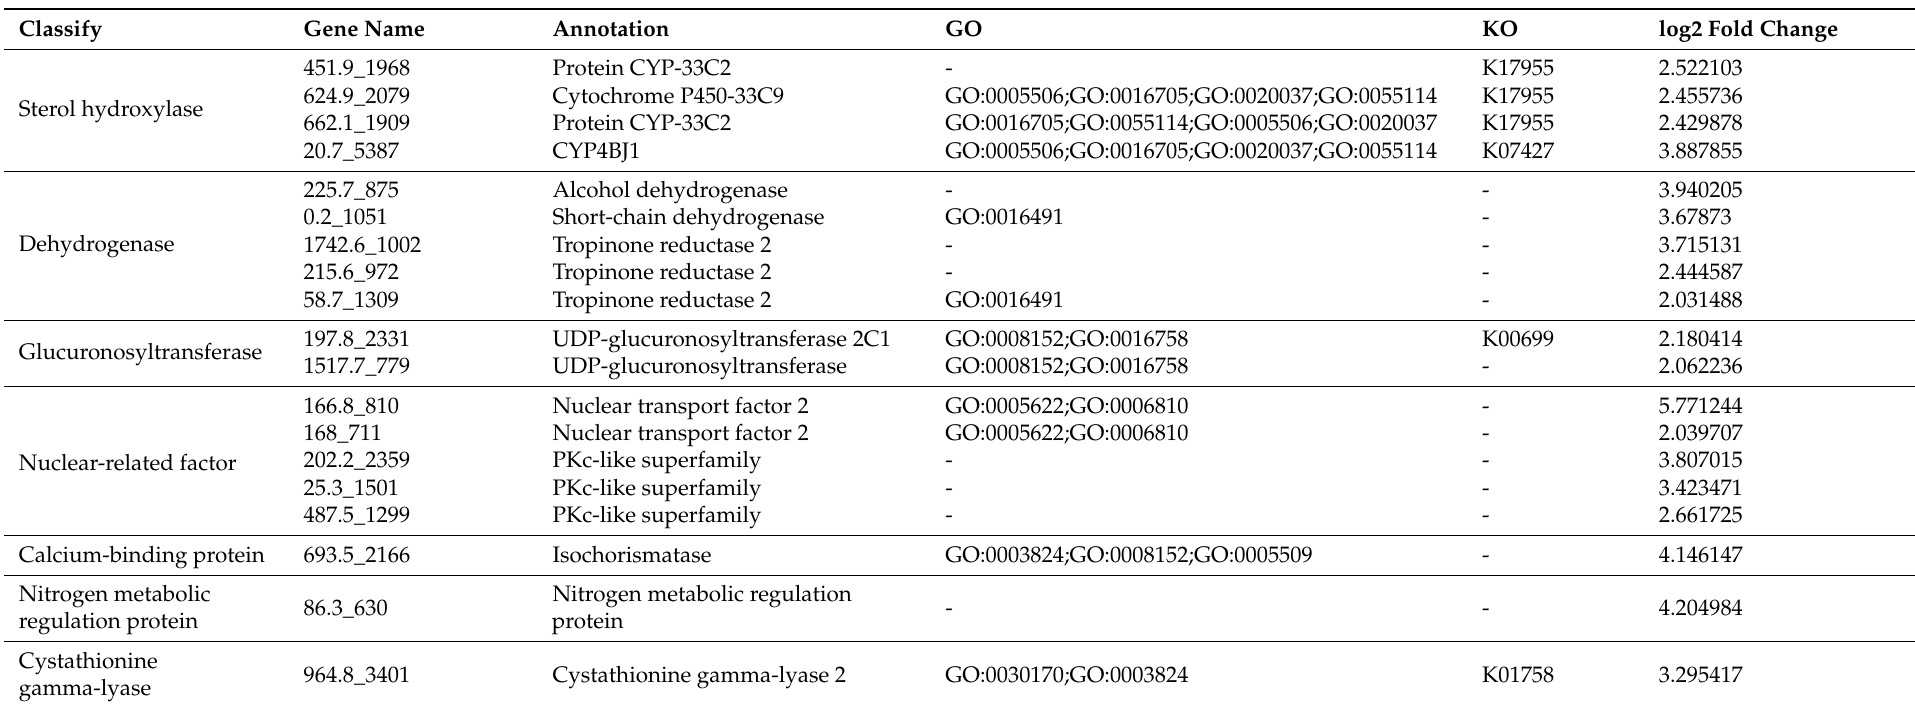
Table 1. Nineteen genes up-regulated significantly in dauer juveniles (J IV ) of Bursaphelenchus xylophilus promoted by β -pinene. KEGG was used for analyzing the pathways of genes and GO for analyzing function